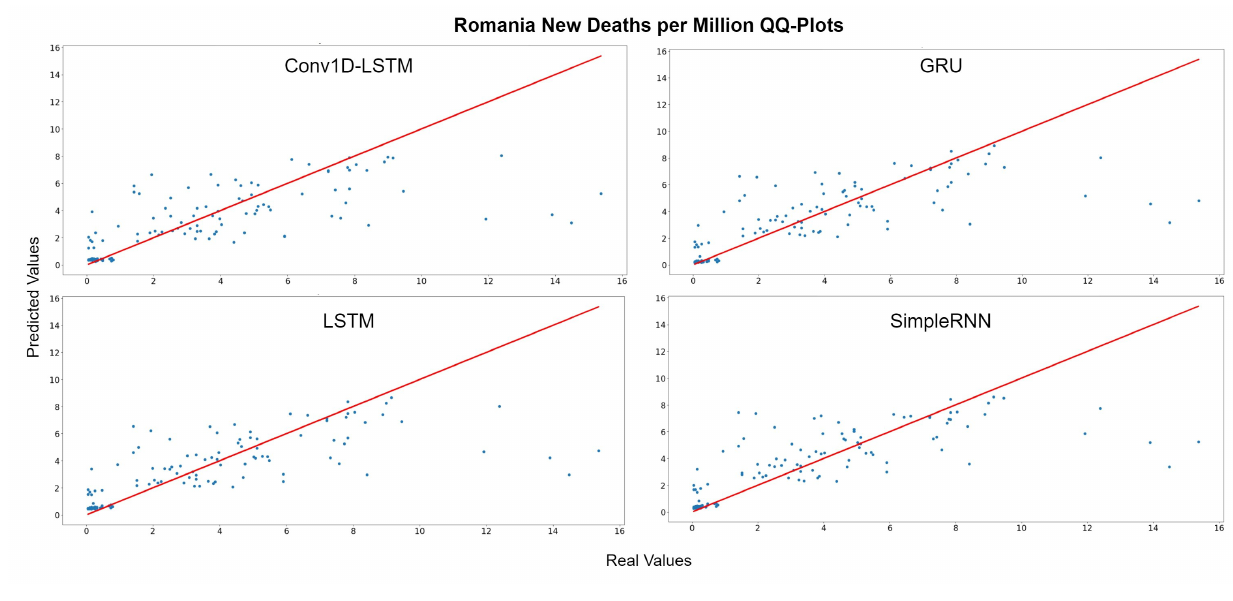
Figure 11. Romania’s new deaths per million QQ-Plot for each method.